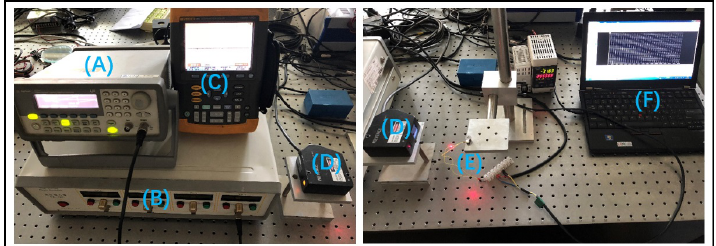
Figure 7. Experimental system: ( A ) signal generator; ( B ) amplifier; ( C ) oscilloscope; ( D ) laser sensor; and ( E ) actuator prototype, ( F )